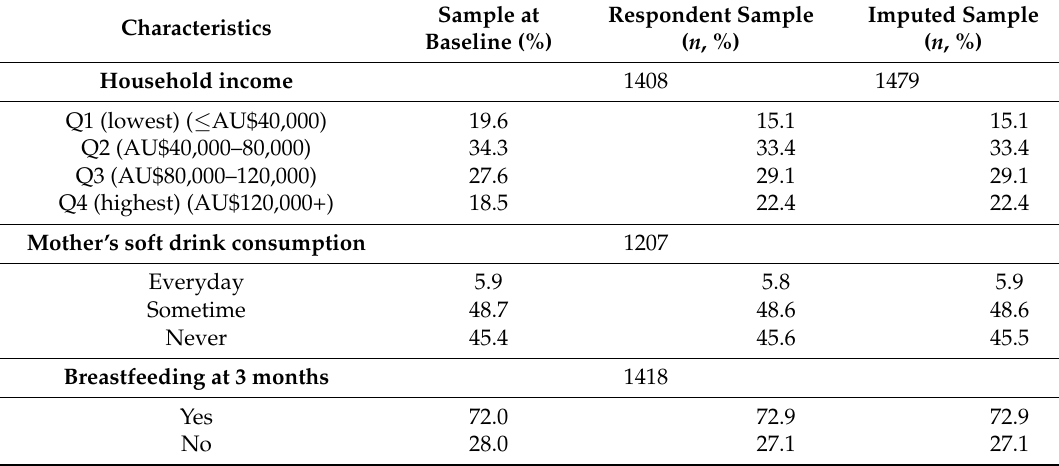
Table 1. Distribution of the exposures and sample